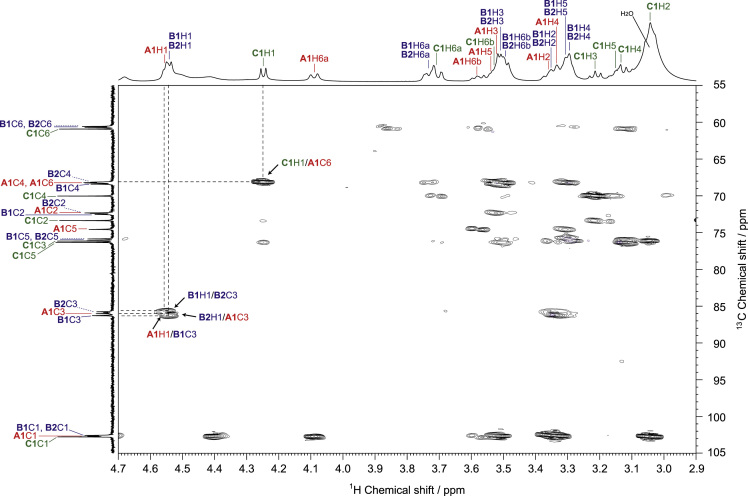
HMBC spectrum of SPG in DMSO-d6 at 363 K. The arrows indicate the interresidual correlations between A1H1–B1C3, B1H1–B2C3, B2H1–A3C3, and C1H1–A1C6 via glycosidic bonds.